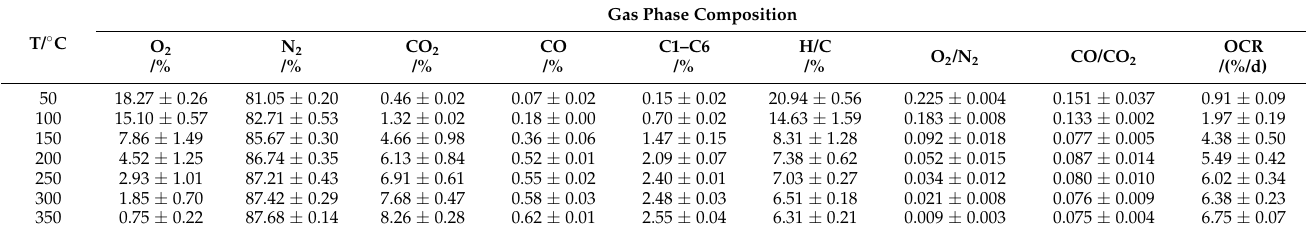
Table 2. The analysis of gaseous products from FC extra-heavy oil isothermal oxidation.